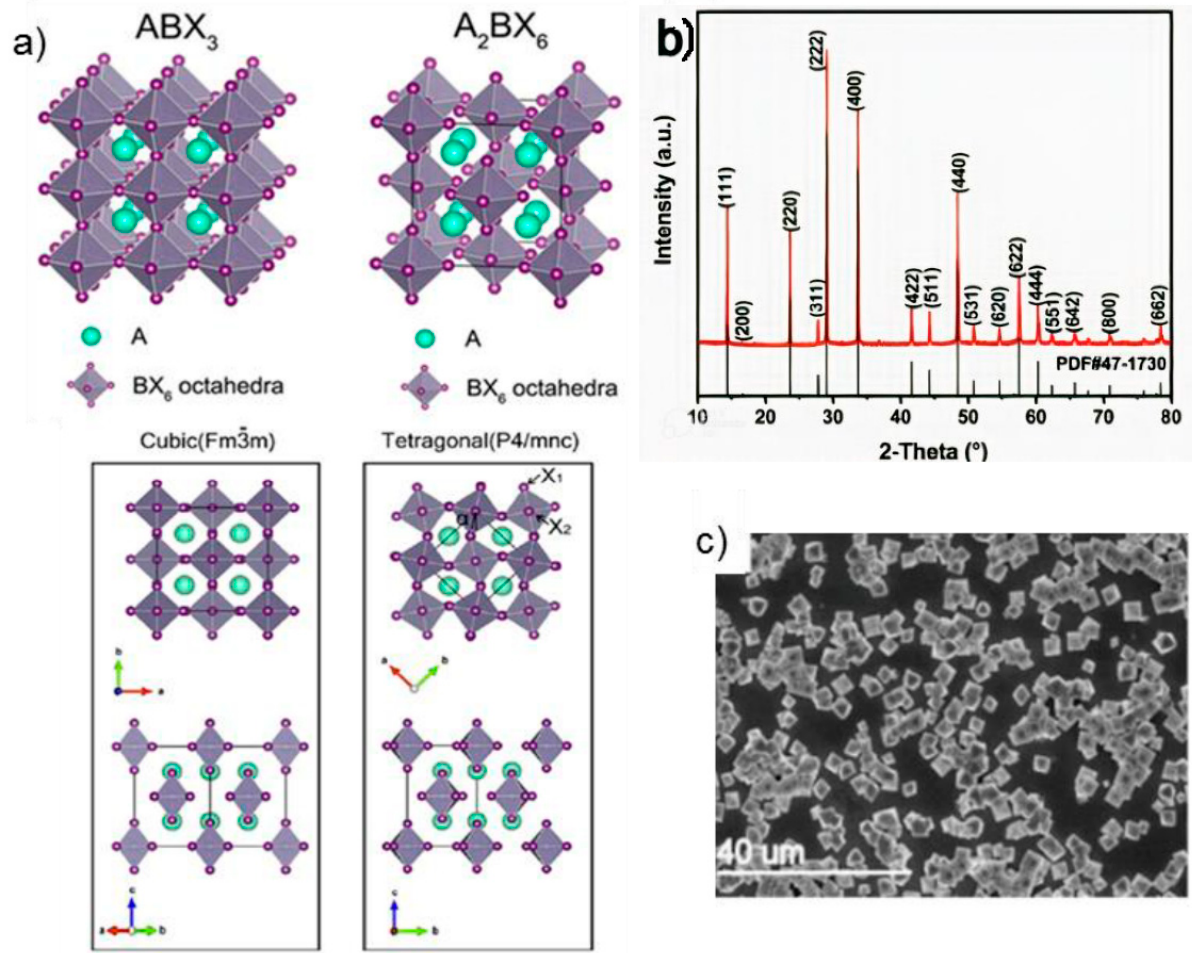
Figure 1. ( a ) Crystal structures of ABX 3 (top left) and A 2 BX 6 (top right), and A 2 BX 6 compound in cubic phase (down left) and tetragonal phase (down right) of polymorphs viewed from various angles. ( b ) XRD pattern of Cs 2 PdBr 6 powders. ( c ) SEM image of Cs 2 PdBr 6 powders. Reprinted/adapted with permission from Ref. [67] . Copyright © 2022, American Chemical Society. and Ref. [37]. Cop- yright ©2020, Royal Society of Chemistry.